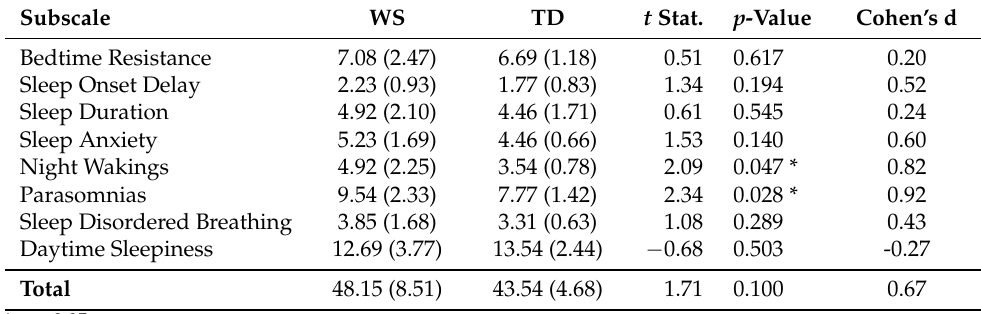
Table 2. Group mean scores, standard deviations, and group differences in CSHQ. Subscale